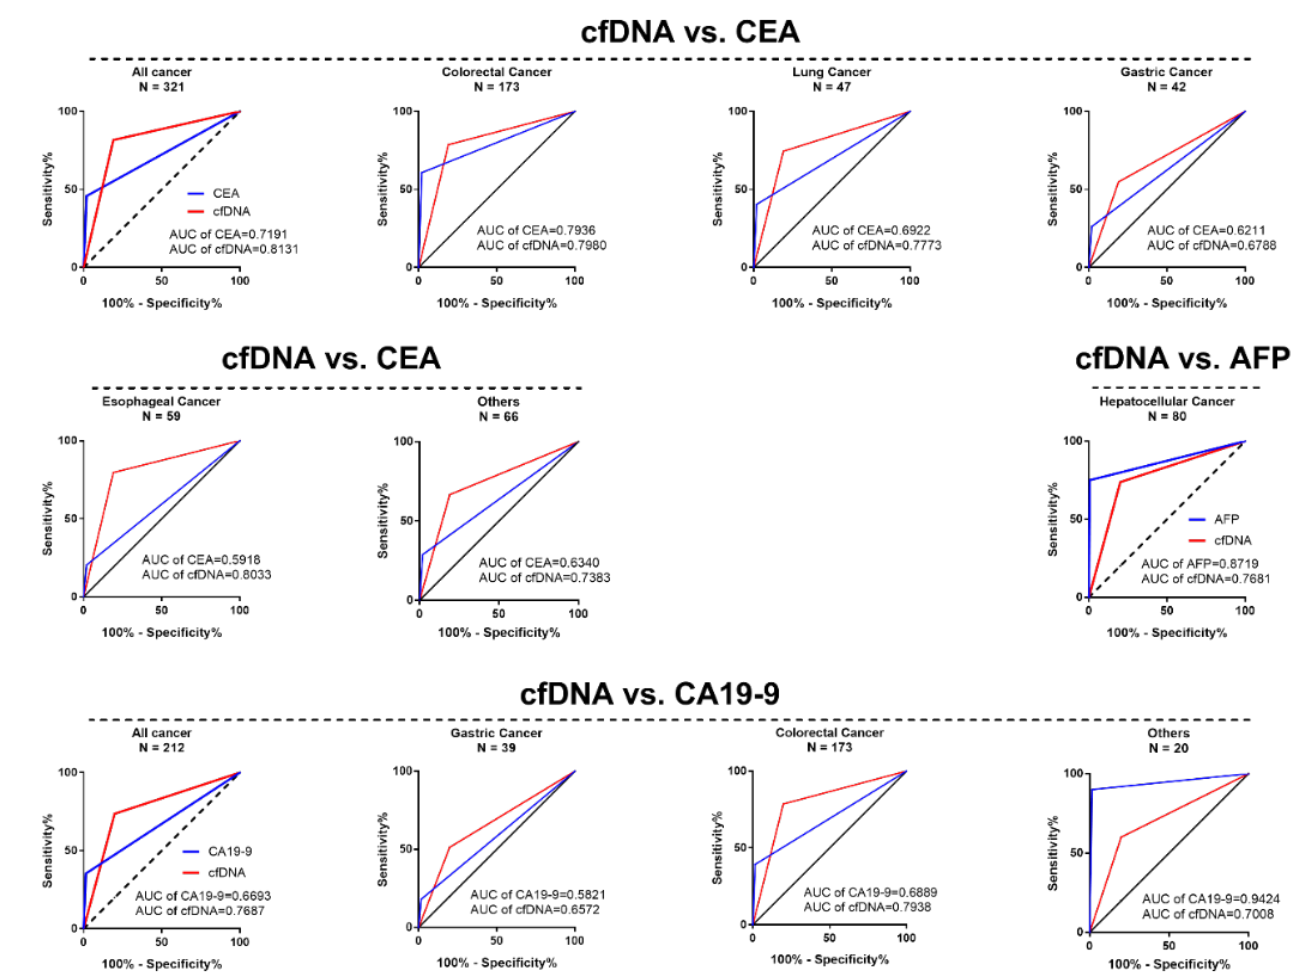
Figure 5. The ROC curve of the cfDNA adsorption rate compared with the tumor biomarkers carcinoembryonic antigen (CEA), CA19-9 and alpha fetoprotein (AFP) in the diagnosis of most malignant tumors.